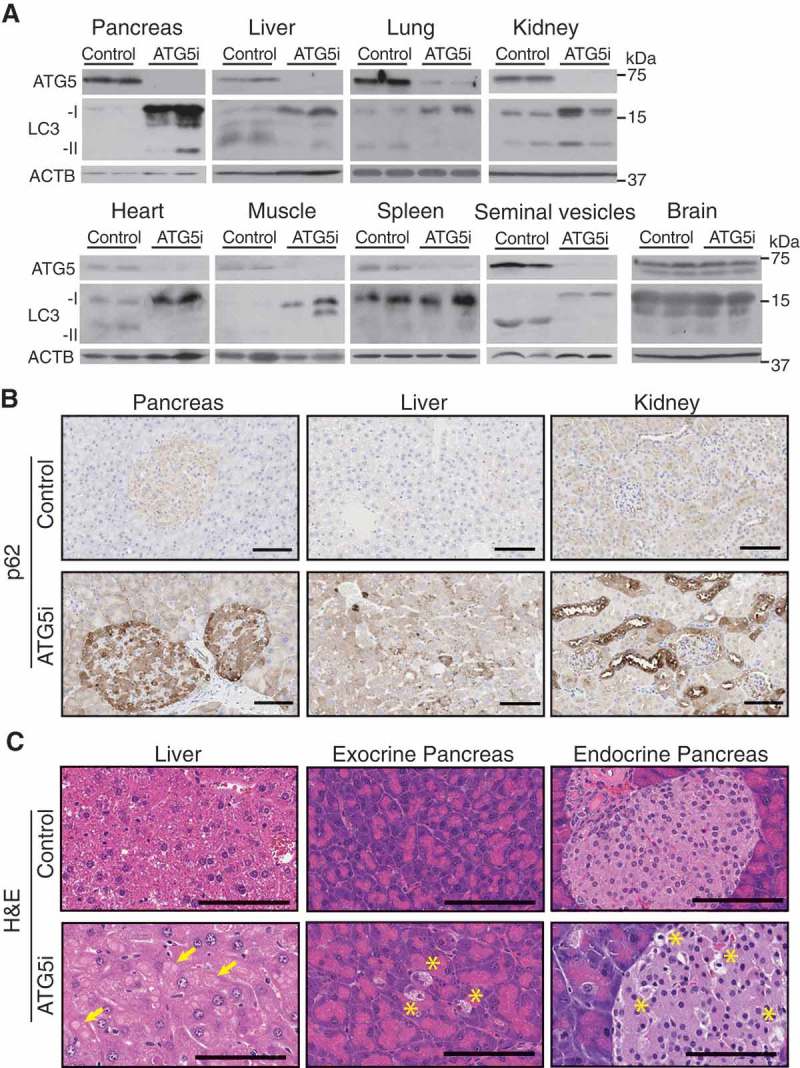
In vivo validation of autophagy inhibition upon Atg5 downregulation. (a) ATG5 shows by western blot a downregulation across a range of tissue in adult mice treated with dox for 6 weeks, except the brain, which displays no alterations in ATG5 in whole tissue extracts. ACTB serves as a loading control in all tissues except for heart and muscle for which total actin was used instead. (b) ATG5i mice display an increase in SQSTM1 in the indicated tissues via IHC. (c) Atg5 downregulation is associated with the development of large proteinaceous aggregates in the liver (yellow arrows). Additionally, cellular degeneration of the exocrine and endocrine pancreas is visible by H&E analysis (yellow asterisk). Scale bars: 100 μm in b and c.